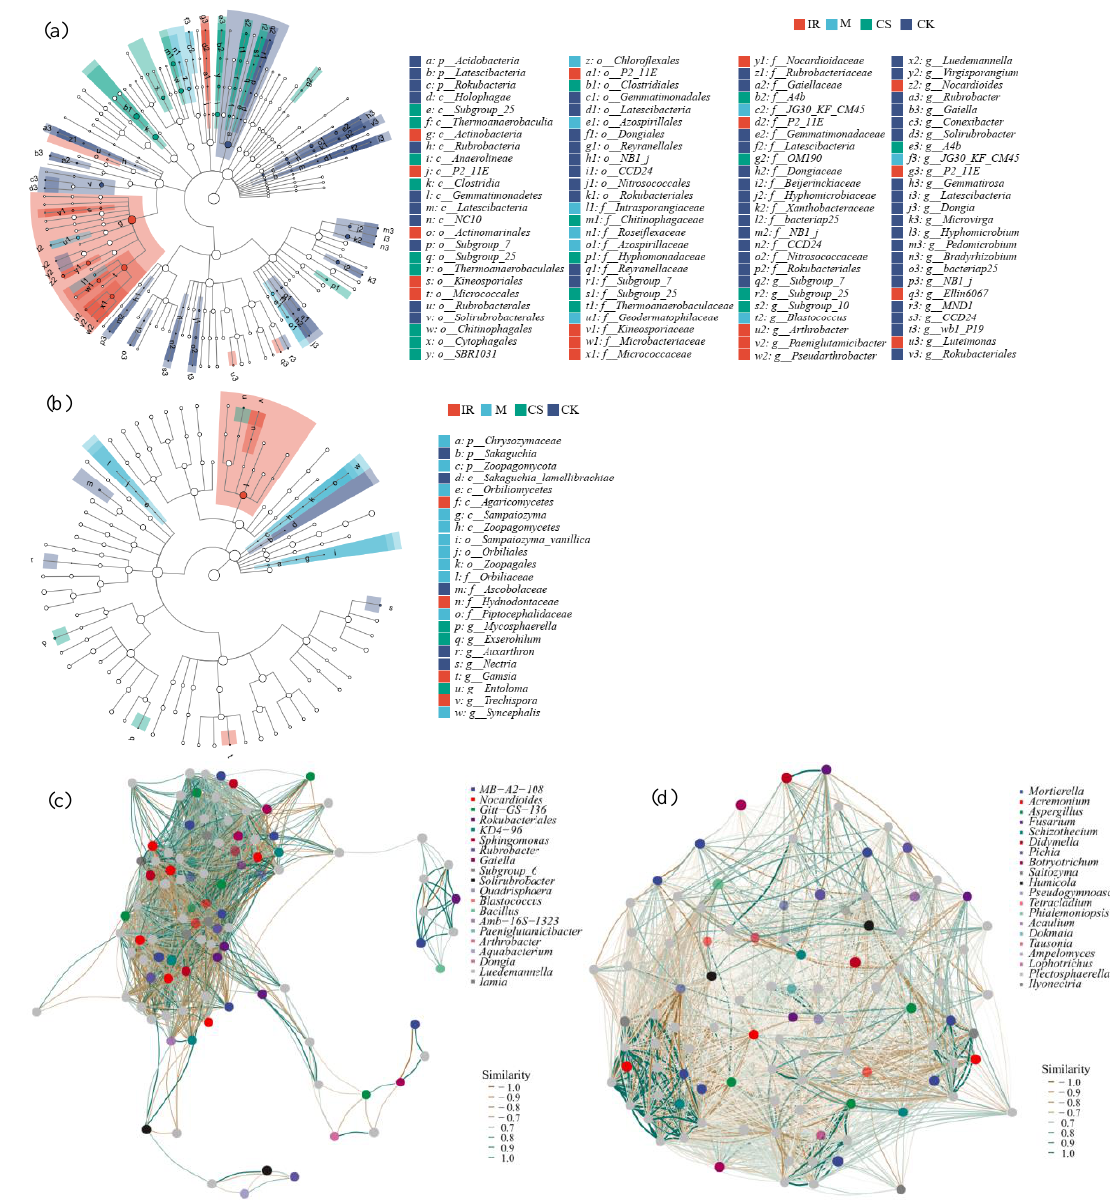
Figure 6. LEfSe and network analyses of soil microbial communities. ( a ) LEfSe analysis of soil bacteria; ( b ) LEfSe analysis of soil fungi; ( c ) network analysis of soil bacteria; ( d ) network analysis of soil fungi. IR, Italian Riesling; M, Merlot; CS, Cabernet Sauvignon; CK, control check (desert land). Nodes in ( a , b ) correspond to the average relative abundance for the indicated taxa, with